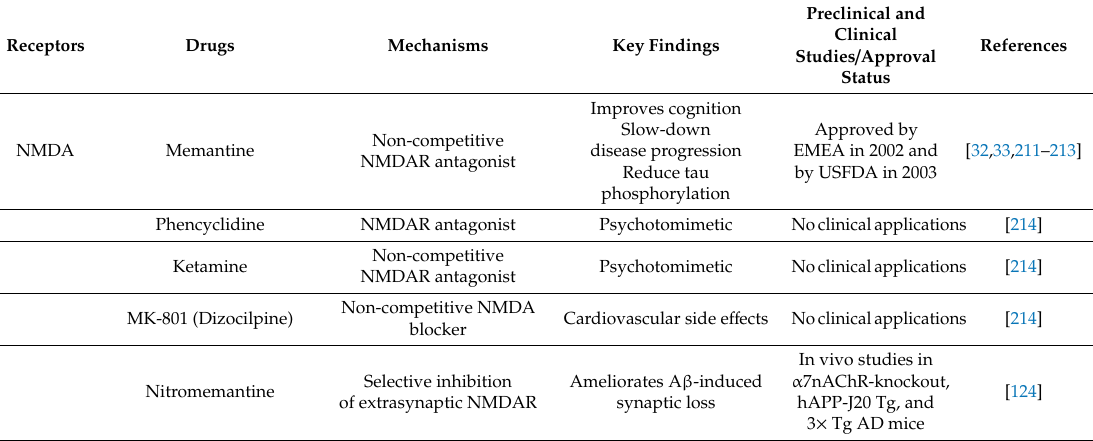
Table 2. List of compounds acting on glutamatergic receptors, transporters and their key findings. Receptors Drugs Mechanisms Key Findings